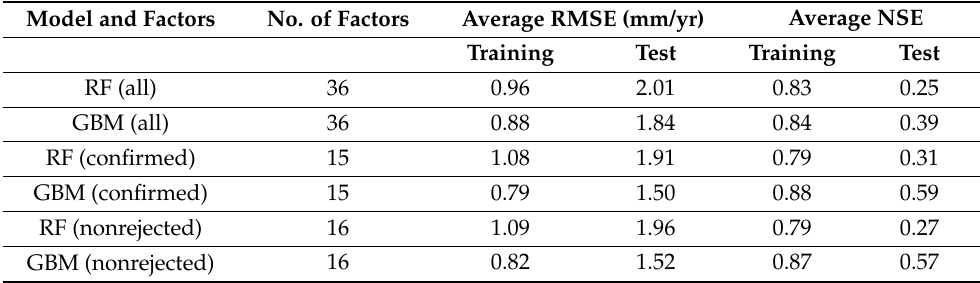
Table 3. Performance comparison of machine learning models using threefold cross-validation. Model and